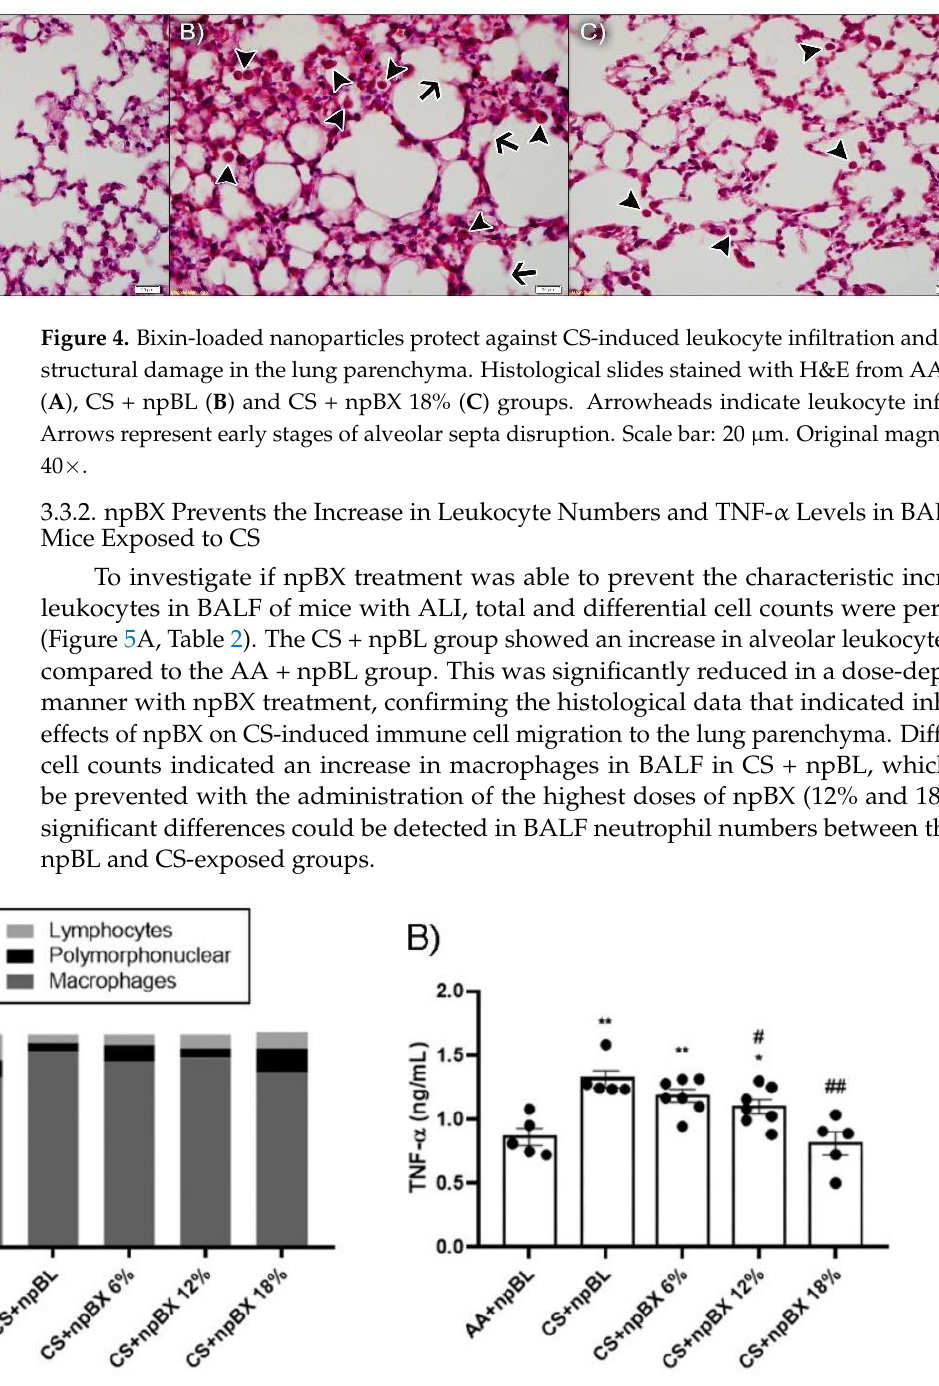
Figure 5. Anti-inflammatory effects of bixin-loaded nanoparticles. ( A ) Total and differential cell counts in BALF. ( B ) TNF- α levels in BALF samples from 8 animals per group as determined by ELISA (AA + npBL n = 5; CS + npBL n = 5; CS + npBX 6% n = 7; CS + npBX 12% n = 7; and CS + npBX 18% n = 5). * p < 0.05 and ** p < 0.01 compared to AA + npBL; # p < 0.05 and ## p < 0.01 compared to CS +